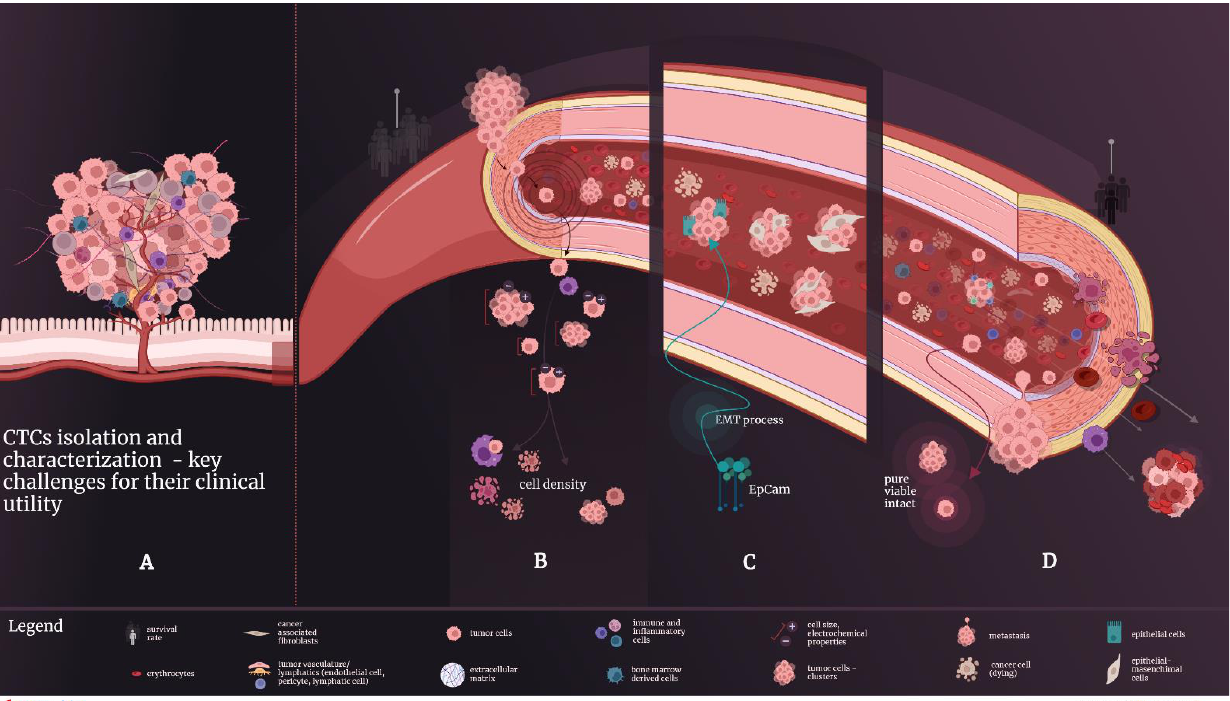
Figure 5. CTC isolation and characterization are key challenges for their clinical utility. ( A ) The complexity of the primary tumor microenvironment affects tumor progression and CTCs and CTC cluster formation. CTCs detach from the primary tumor as single cells and clusters, shed into the bloodstream, and migrate to colonize in distant organs, known as metastasis. The predictive significance of CTC analysis includes the detection of CTCs in the early stage of malignancy in resectable solid tumors.The CTC isolation methods are based on the differences between target CTCs and blood cells. These differences include physical properties (size, density, electrical charge, and deformability) and specific biological characteristics (expression of surface protein markers and viability).The specific features of CTCs make their isolation methods very demanding: (B) The low concentration of CTCs in the blood (estimated as 1 – 10 single CTCs and 1 CTC cluster per 1 mL of